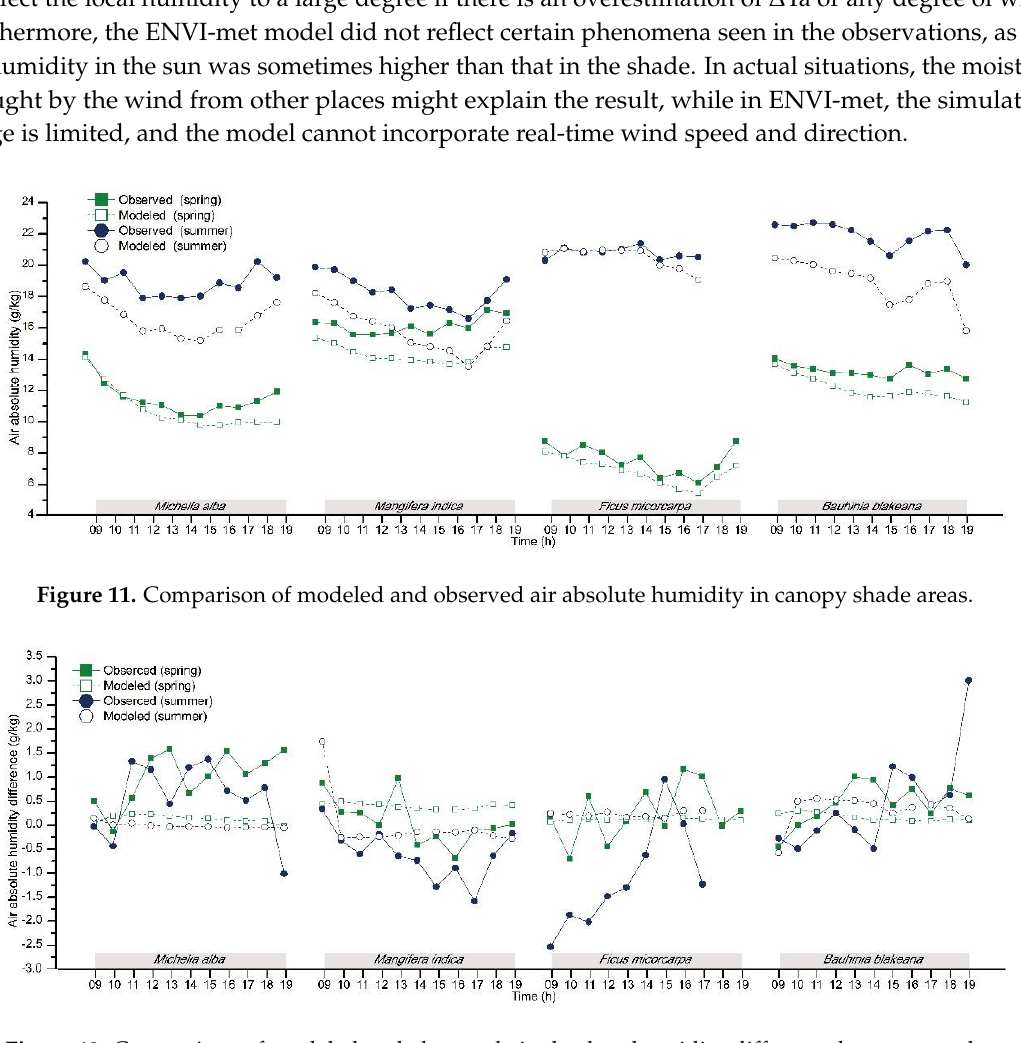
Figure 13. Comparison of modeled and observed air absolute humidity in the tree crown in four directions.